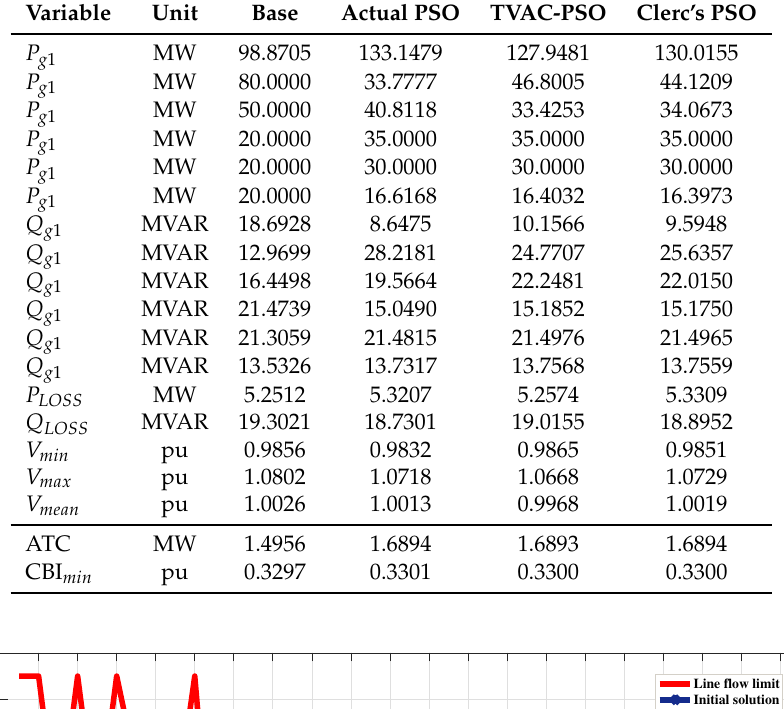
Table 3. Analysis of optimal solution for T1: 2–28.